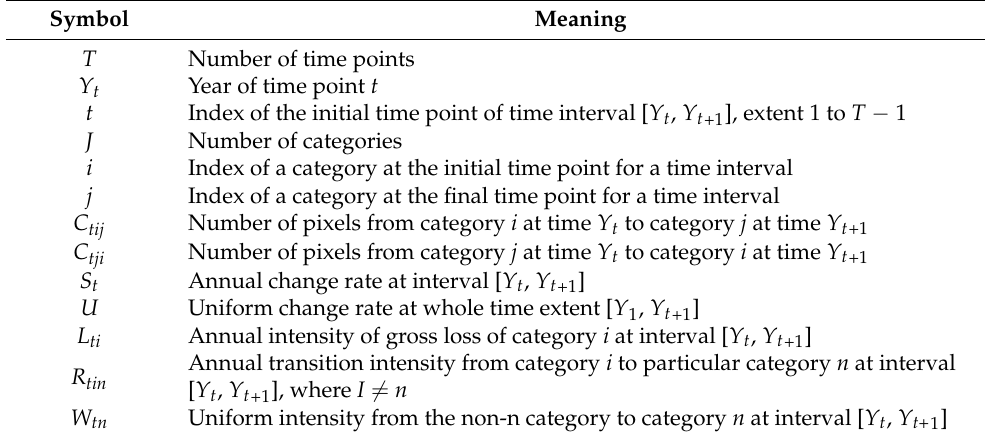
Table 1. Mathematical notation of Intensity